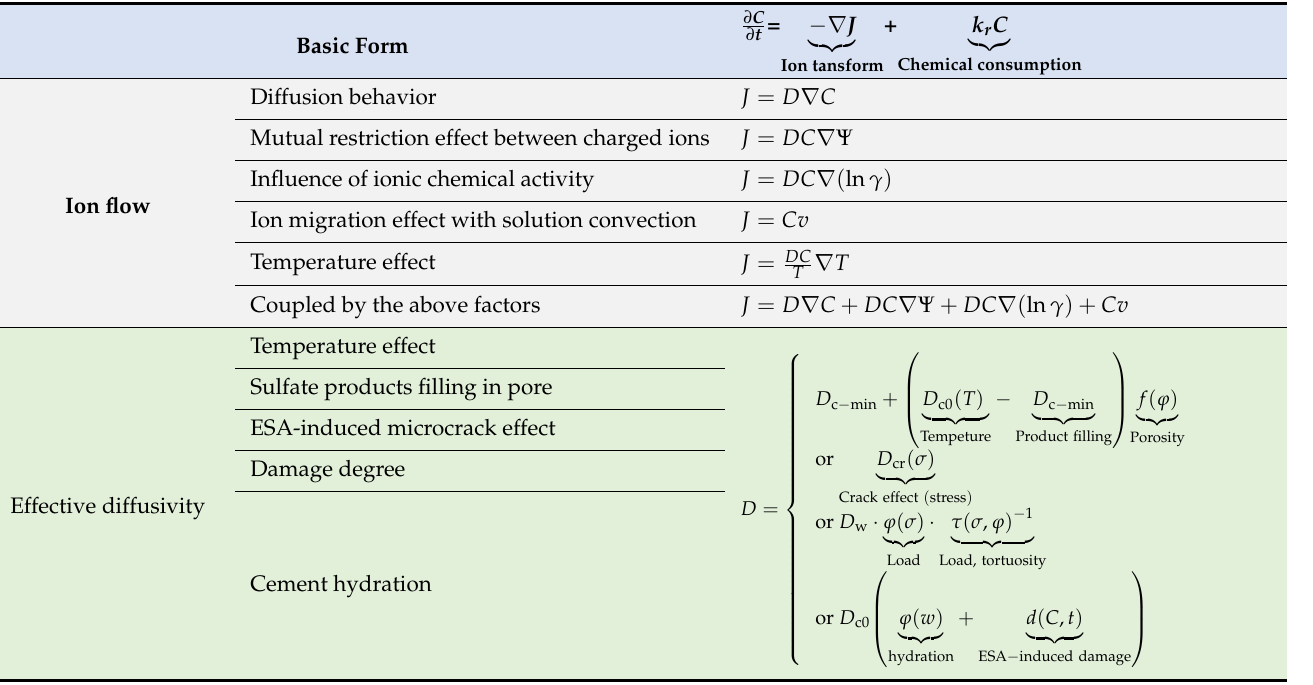
Table 3. Influence factors of sulfate ion transport in